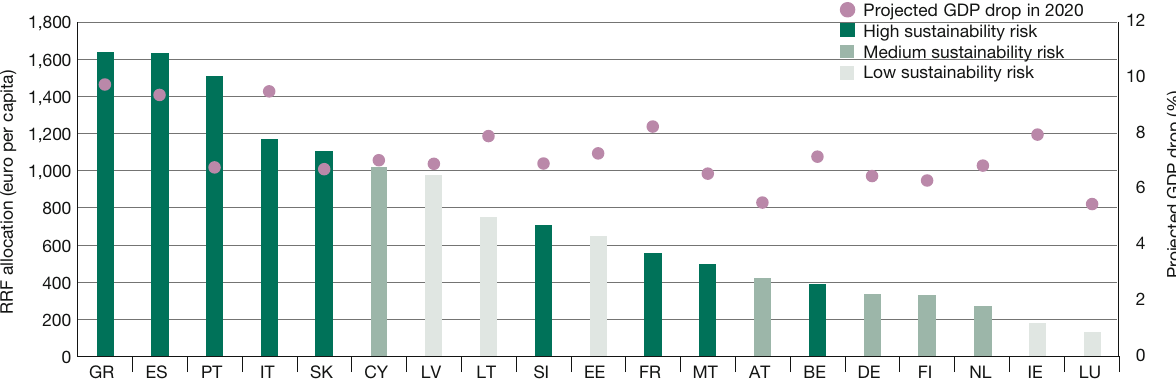
Recovery and Resilience Facility allocation per capita and fi scal sustainability, euro area